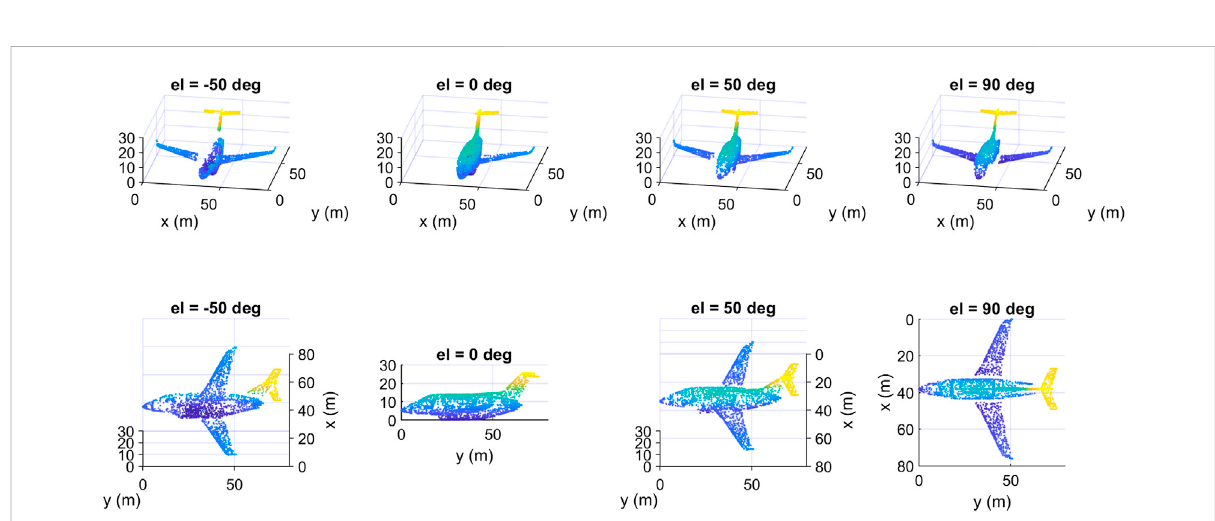
FIGURE 11 Some data samples of the class “ airplane ” of the created dataset at different elevation angles: top) fi xed viewpoint, down) camera ’ s viewpoint.